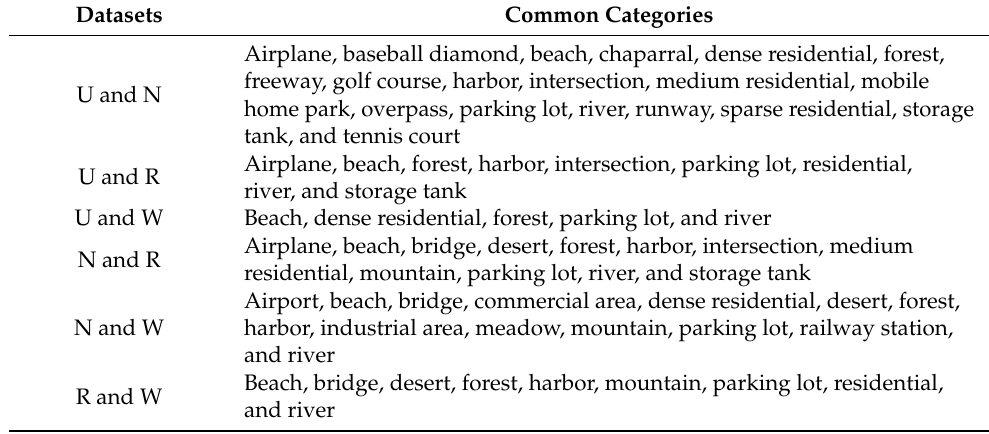
Table 2. Common categories of